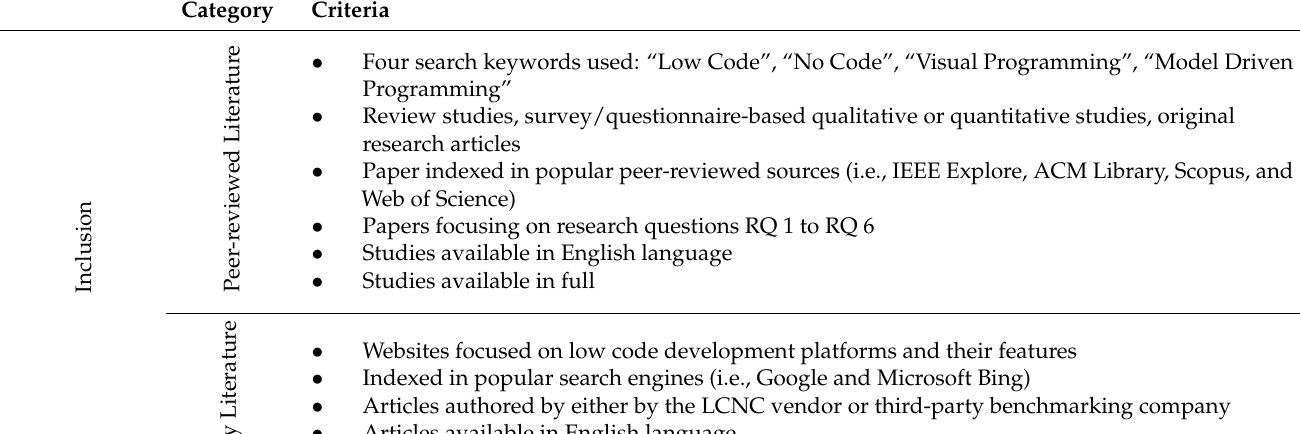
Table 2. Inclusion and exclusion criteria for both peer ‐ reviewed and grey literature. Category Criteria